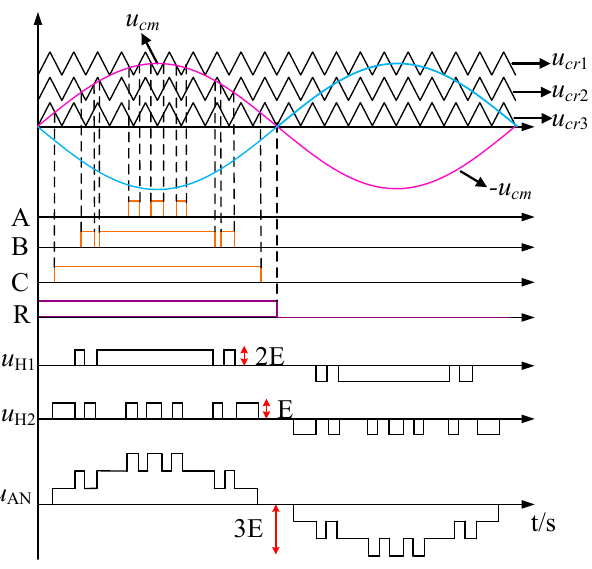
Figure 6. Unipolar level-shifted PWM (LS-PWM) modulation strategy schematic diagram (Reference [17]).